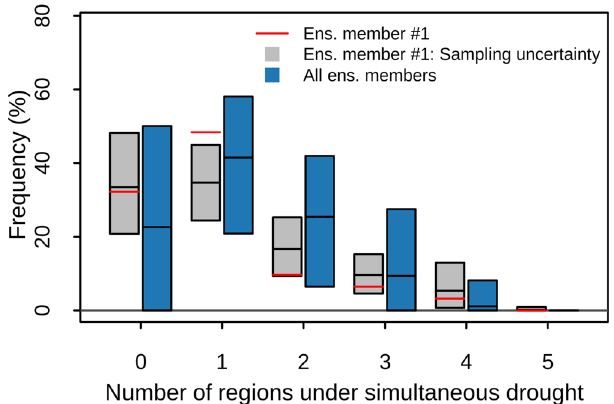
Fig. 8 | Evaluating statistical modelling of compound events using large ensemblesimulations. BluebarsasinFig.5b.Redline,thehistoricalprobabilityof annual soil moisture drought in N simultaneous regions based on data of the fi rst ensemble member. Grey bar, sampling uncertainty (centred 95% con fi dence interval) inthe historicalprobability estimated throughastatisticalmodel fi tted to data of the fi rst ensemble member (the mean prediction of the statistical model is shown by the black